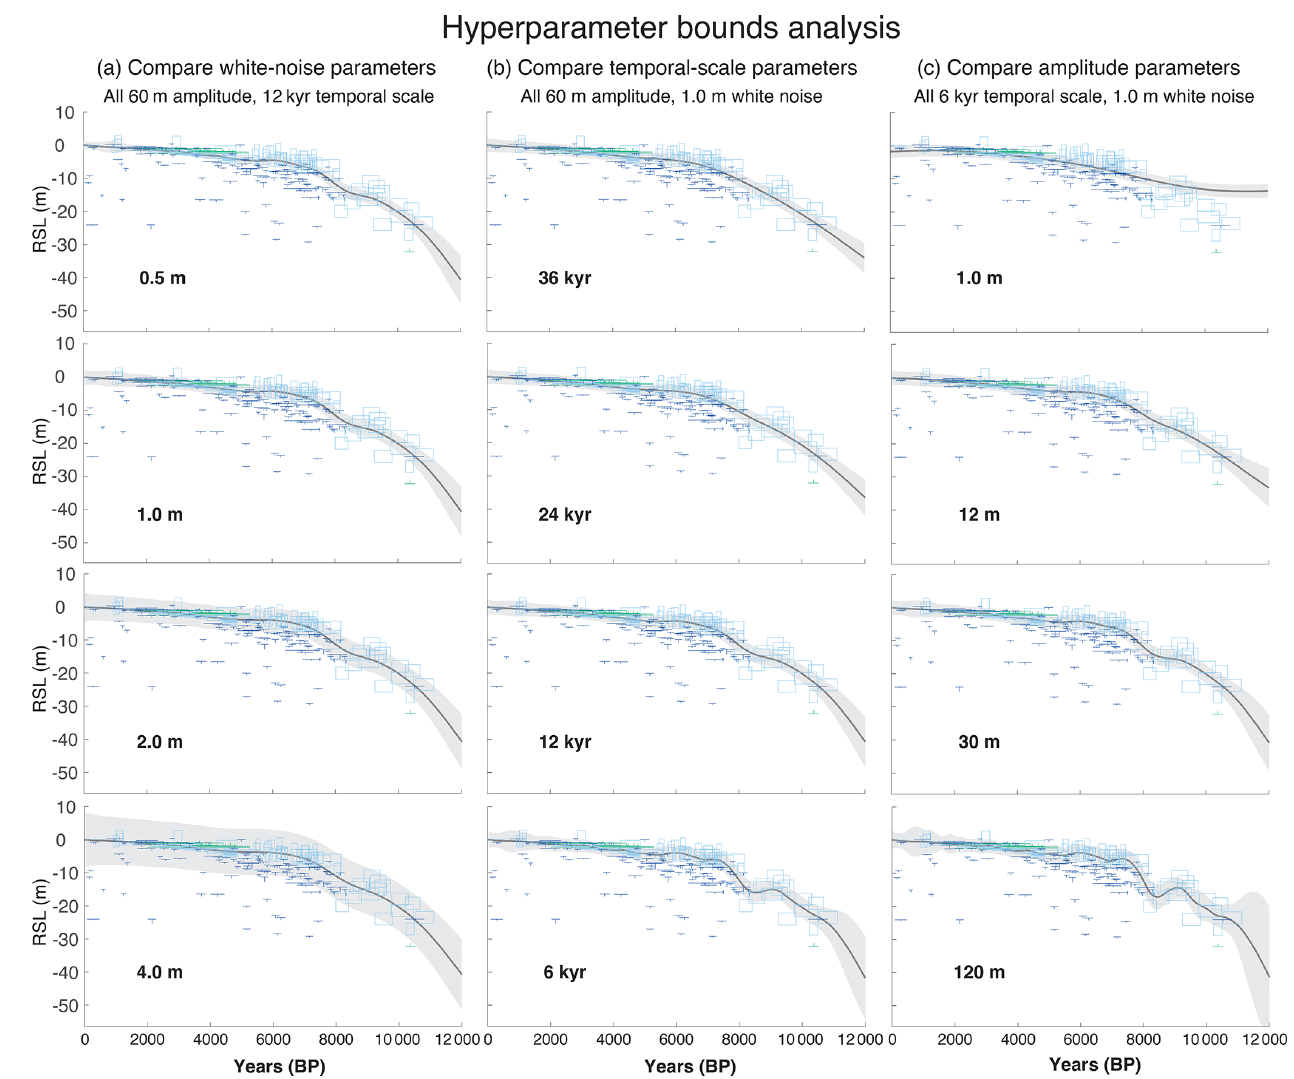
Figure C1. Examples of various hyperparameter combinations and the way they influence how the same data are interpreted and reflect the predicted relative sea level